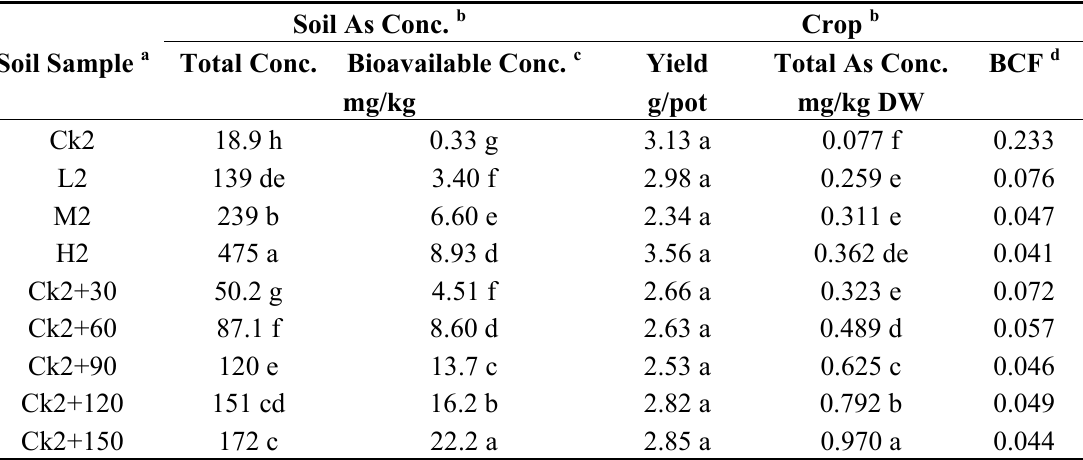
Table 2. Total and bioavailable As concentrations of nine studied soils and total As in the edible part of loose leaf lettuce. Soil As Conc. b Crop b Soil Sample a Total Conc. Bioavailable Conc. c Yield Total As Conc.